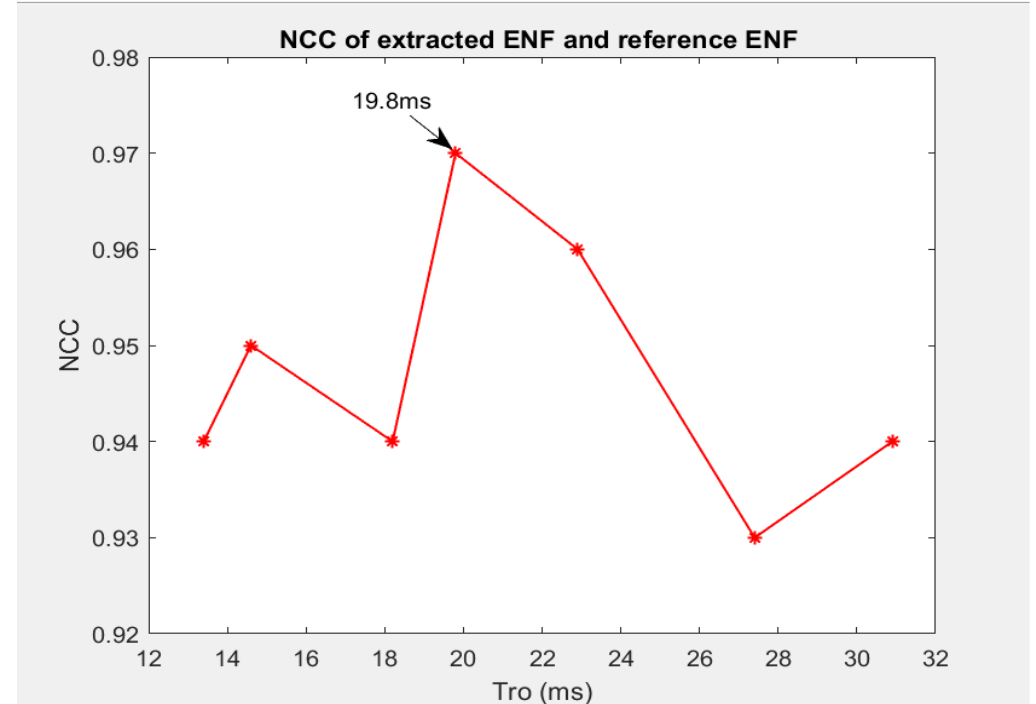
Figure 8. NCC of the extracted ENF and the reference ENF.